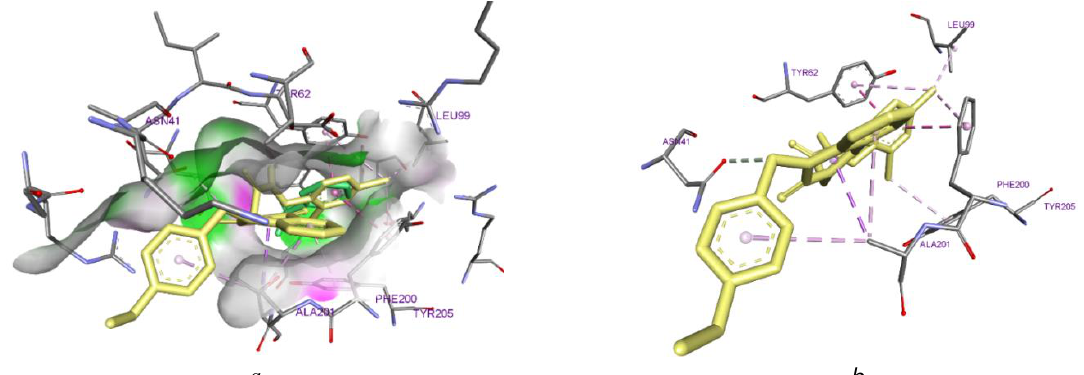
Figure 5. 3D visualization of 3.9 ligand (yellow molecule): а – with ВА (green molecule); b – after interrelation with